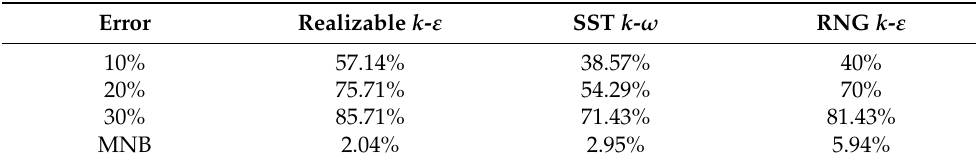
Table 1. Analysis of velocity error between different turbulence models and